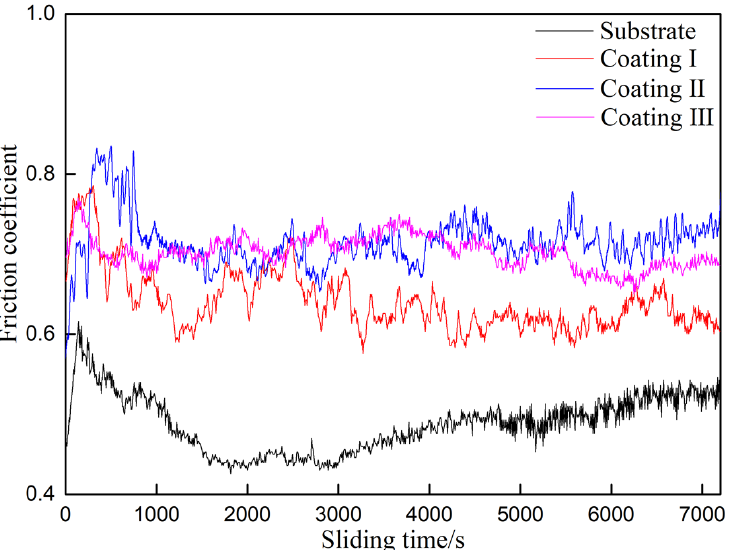
Figure 9. The relationship between friction coefficient and sliding time of the substrate and the coatings subject to friction in 3.5 wt.% NaCl solution.